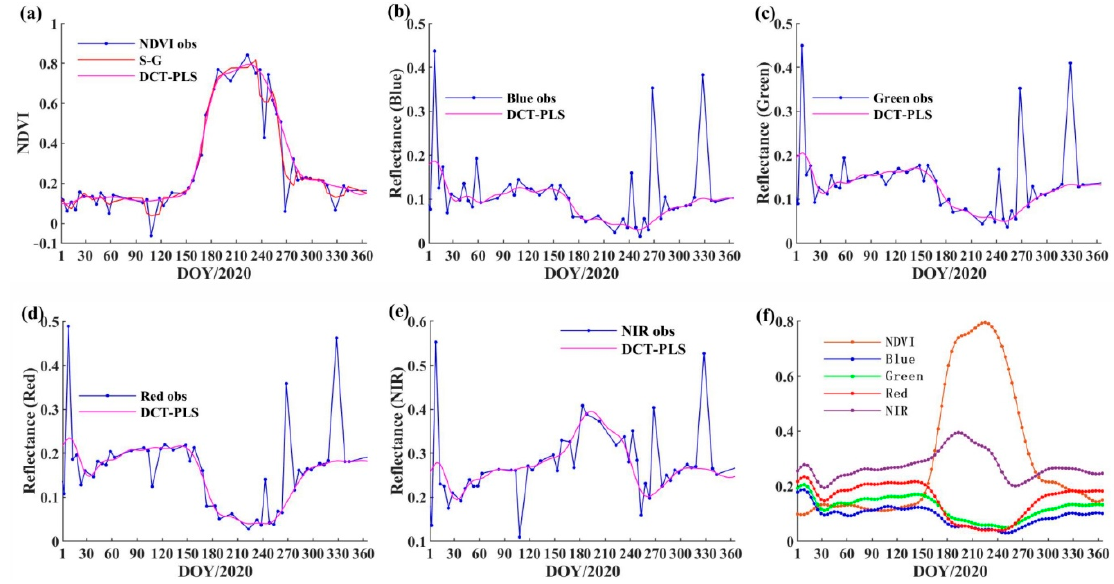
Figure 6. The comparison of NDVI and band reflectance time series from Sentinel-2, the DCT-PLS and SG filter methods for the corn sample in 2020. ( a ) The NDVI time series; ( b – e ) The surface reflectance time series in blue, green, red and NIR band, respectively; ( f ) The reconstructed NDVI and all the band reflectance time series from the DCT-PLS method.